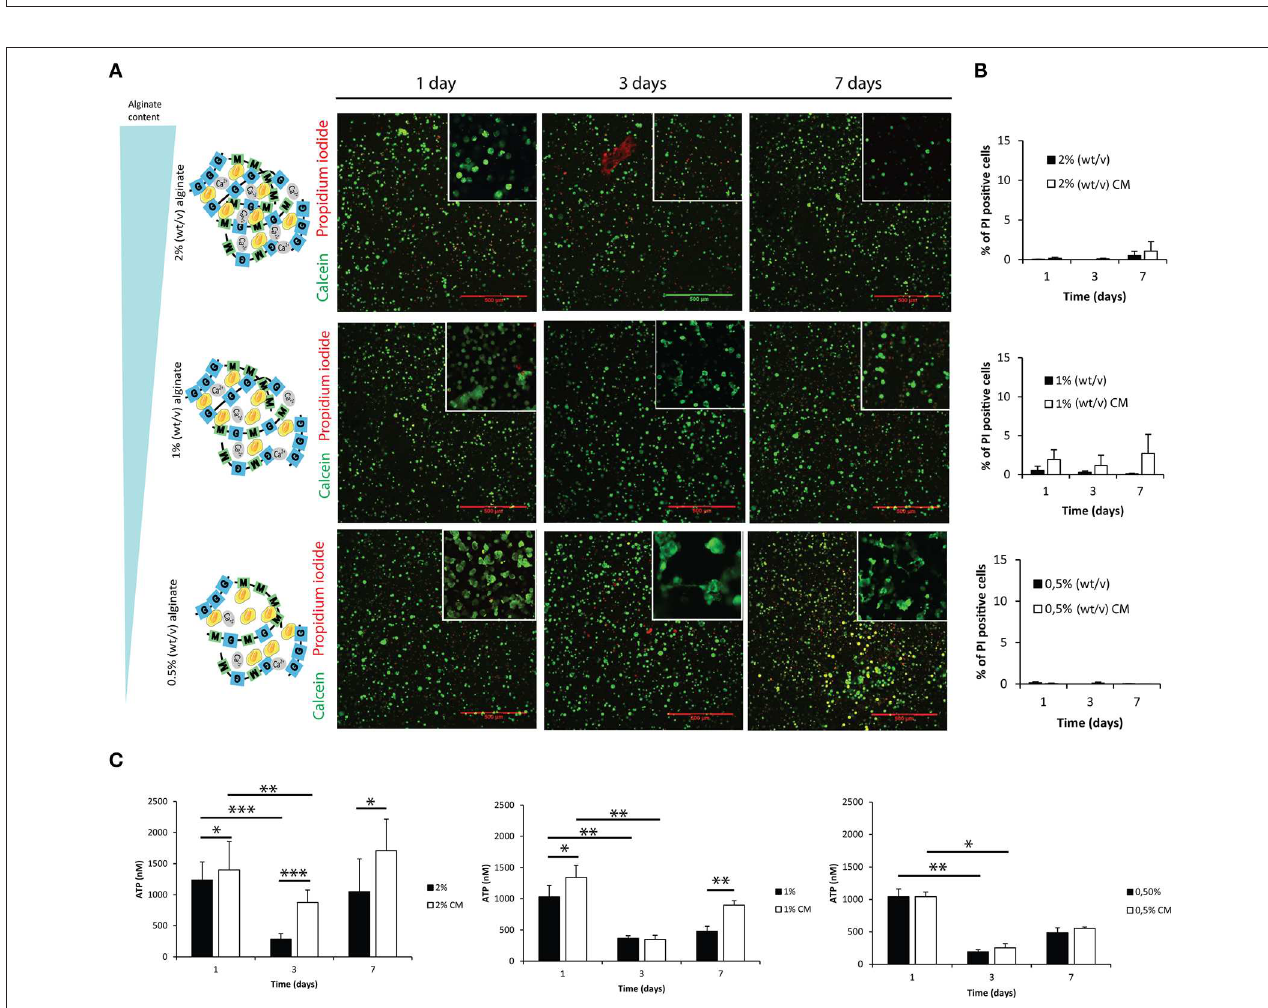
FIGURE 2 | Evaluation of cell viability and metabolic activity within 3D alginate discs. Results are shown as mean ± standard deviation; asterisks represent statistical differences * p < 0.05 , ** p < 0.01 , *** p < 0.001 (A) Representative photos of live-dead assay for astrocytes cultured in the presence of fibroblast conditioned medium (CM). Live cells are stained with Calcein-AM (green) and dead cells are stained with propidium iodide (red); (B) Quantification of dead cells (propidium iodide) by FACS analysis at 1, 3, and 7 days of culture ( n = 3 pools of 10000 events); (C) ATP levels of the 3D culture astrocytes at 1, 3, and 7 days of culture ( n = 6 ).